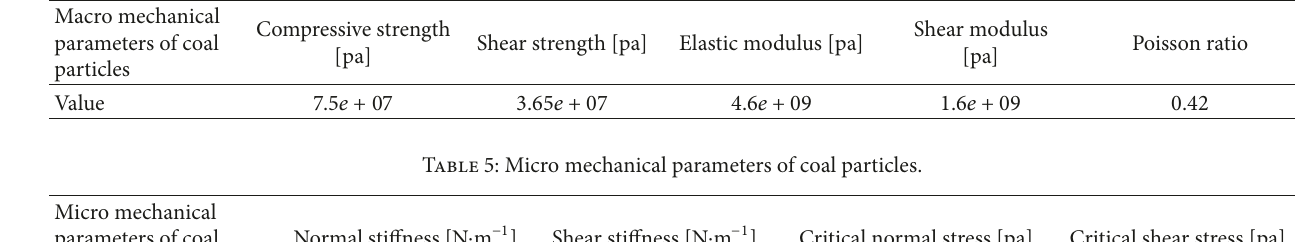
Table 4: Macro mechanical characteristic parameters of coal particles.